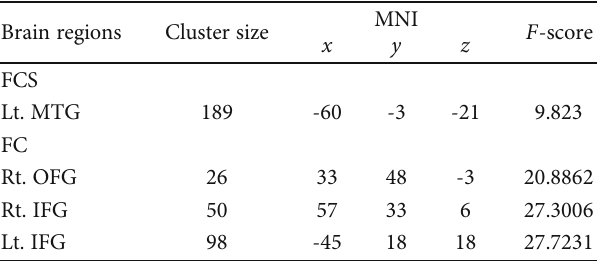
Table 2: FCS di ff erences and left MTG FC di ff erences among subjects with aMCI and VaMCI and